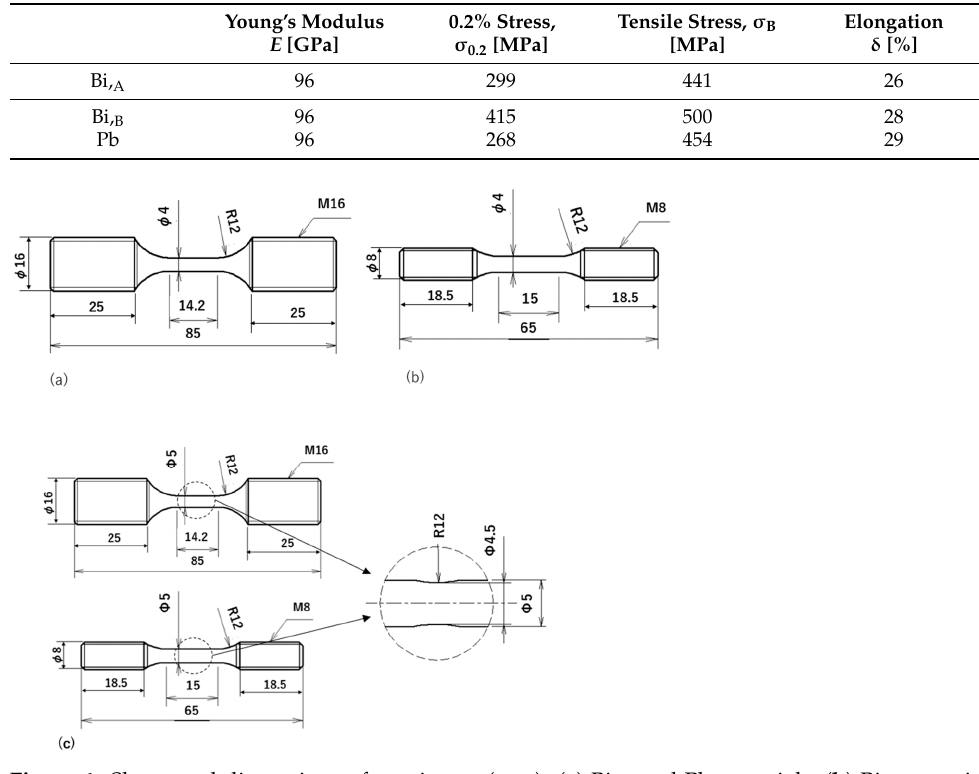
Figure 4. Shape and dimensions of specimens (mm): ( a ) Bi, A and Pb materials; ( b ) Bi, B material; ( c ) and FCG tests. Table 2. Mechanical properties of the materials used.